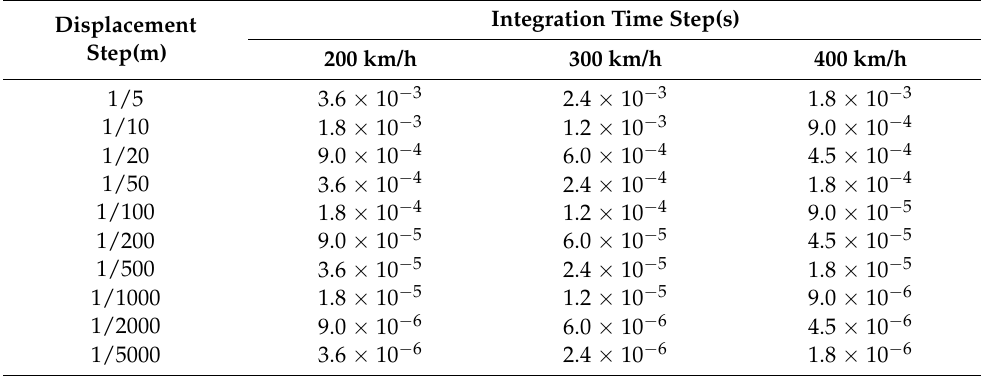
Table 3. Integration Time Step Values at Different